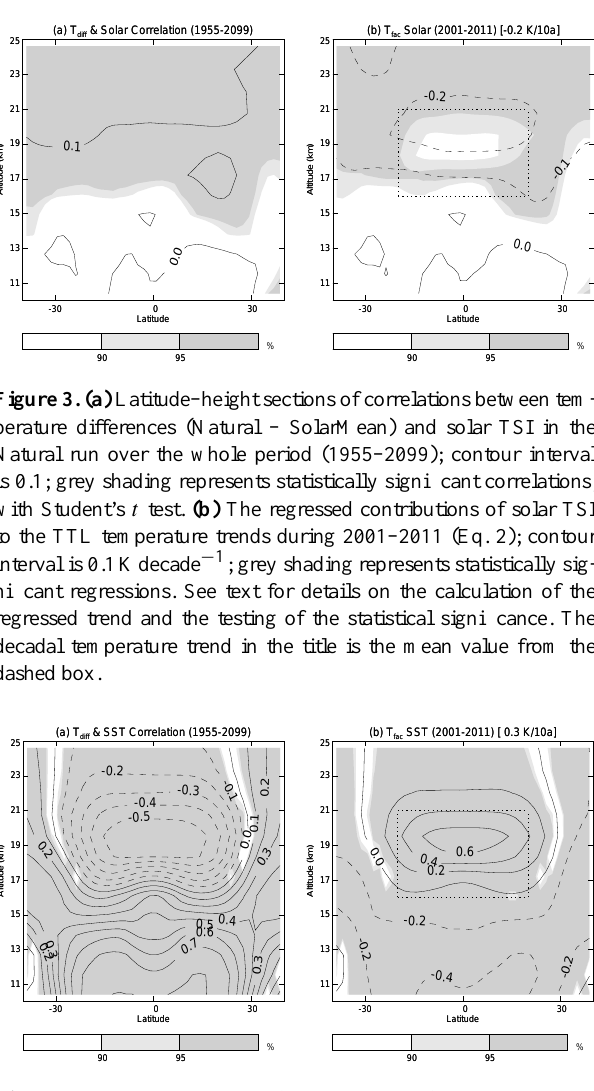
Figure 4. Same as Fig. 3 but for the impact of tropical SSTs by comparing the Natural and FixedSST runs. Contour interval is (a) 0.1 and (b) 0.2Kdecade − 1